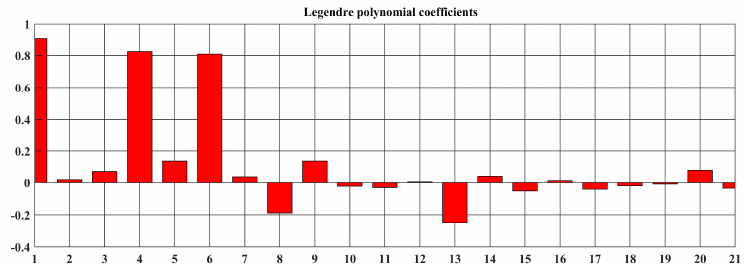
Figure 8. 2D Legendre polynomial coefficients for wavefront distortion without fixed O-rings at 1 Hz.